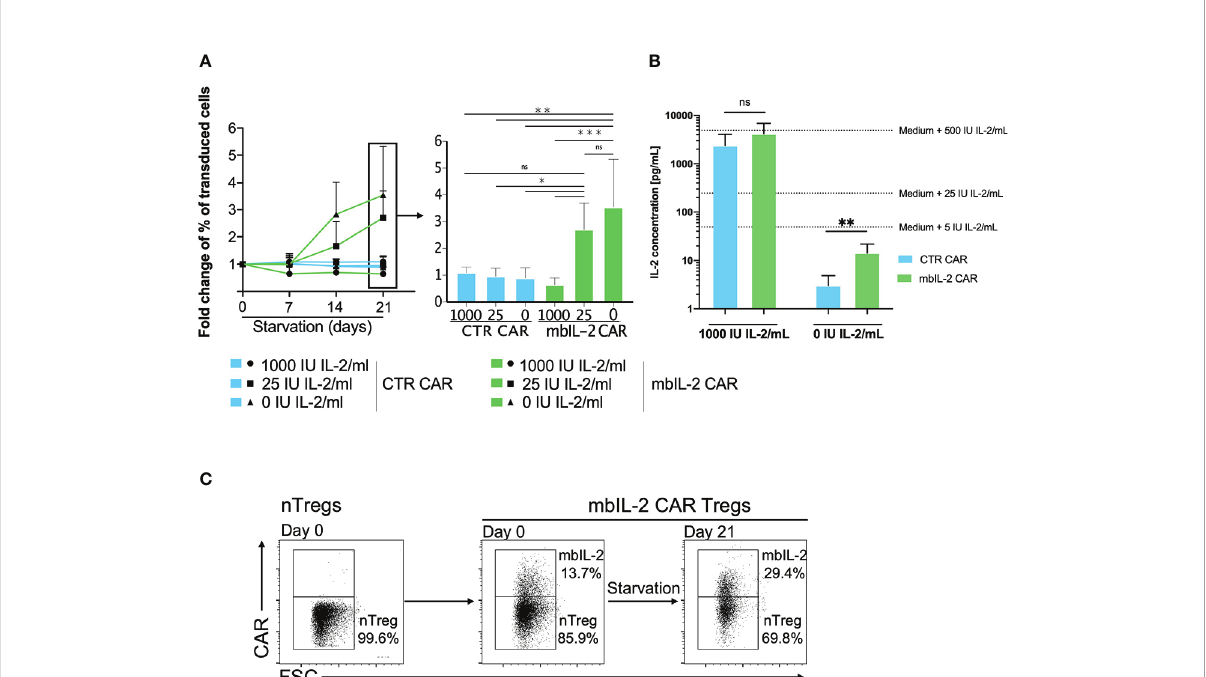
FIGURE 3 Membrane-bound IL-2 enabled Treg survival under IL-2-limiting conditions. (A) Left: Analysed fold change [%] of transduced cells for CTR CAR- Tregs and mbIL-2 CAR-Tregs at the indicated timepoints. Right: Bars represent a summary of all experiments performed on starvation day 21. mbIL-2 led to increased proliferation of mbIL-2 CAR-Tregs in IL-2-deprived or IL-2-free cultures. No difference in fold change was seen in mbIL-2 CAR-Tregs cultured with 25 U (2.70 +/- 0.99) or 0 U IL-2 (3.54 +/- 1.79) exogenous IL-2. In direct comparison, CTR CAR-Treg proliferation under nonphysiological conditions with 25 U (0.96 +/- 0.31) or 0 U (0.89 +/- 0.39) exogenous IL-2 was signi fi cantly lower (n=4, 3 different individuals). The normality of the distribution was assessed using the Shapiro − Wilk normality test. Signi fi cance was calculated with ordinary one-way ANOVA followed by Dunnett ’ s multiple comparison. Error bars show the mean ± SD. ns = not signi fi cant, *P ⪬ 0.05, **P ⪬ 0.005, ***P ⪬ 0.001. (B) Measurement of IL-2 concentrations in the supernatant of Tregs cultured in 0 U IL-2 medium using the BioPlex Cytokine 27-plex Assay system (Bio-Rad). Extrapolated medium IL-2 concentrations were calculated using control media with 1000 U IL-2/mL and 0 U IL-2/mL. Release of up to 14.33 pg/mL (+/- 7.54) was seen in mbIL-2 CAR-Treg culture medium. Signi fi cance was analysed using an unpaired t test. Error bars show the mean ± SD. ns = not signi fi cant, **P ⪬ 0.01. (C) To evaluate the effects of the soluble IL-2 concentration in the mbIL-2 CAR-Treg supernatant on nTregs, mbIL-2 CAR-Tregs and nTregs were cocultured at a ratio of 1:6 (14% vs. 86%) for 21 days under IL-2-free conditions. Flow analysis at day 21 revealed an increase in mbIL-2 of up to 30% and a concomitant shift in nTreg proportion of up to 70%, corresponding to a decrease in the original ratio to 1:2.3 (representative dot plots, n=3, 3 different